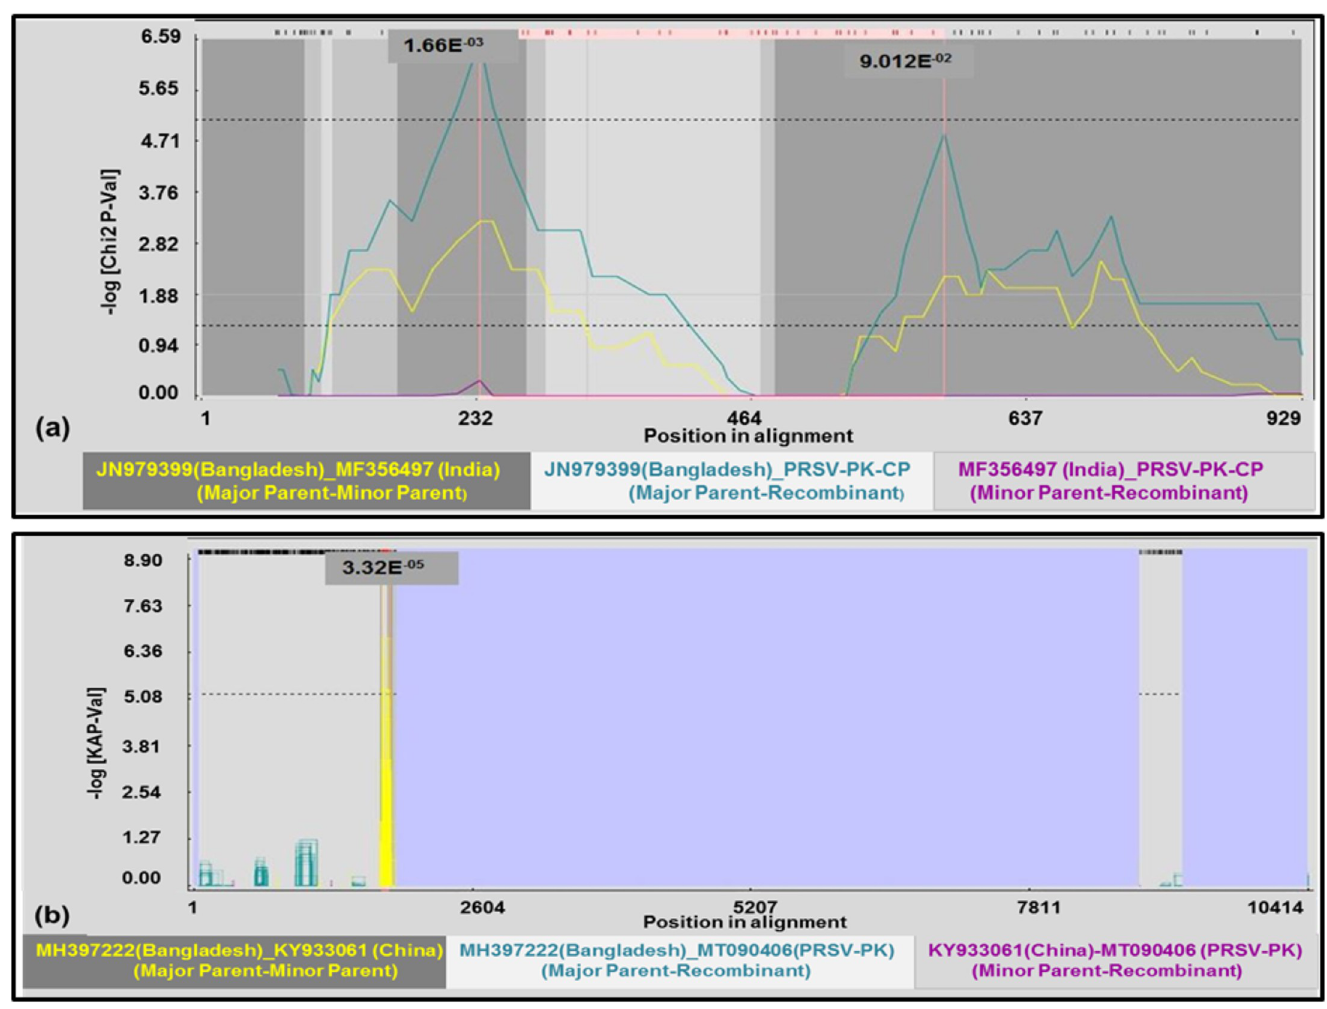
Fig 4. Recombination detection in PRSV-PK-CP gene and full-length genomic sequence. a) Maxchi plot built in RDP indicting the potential breakpoints in the recombinant PK-CP gene b) GeneConversion plot built in RDP indicating potential breakpoints in the full length PRSV-PK genome.